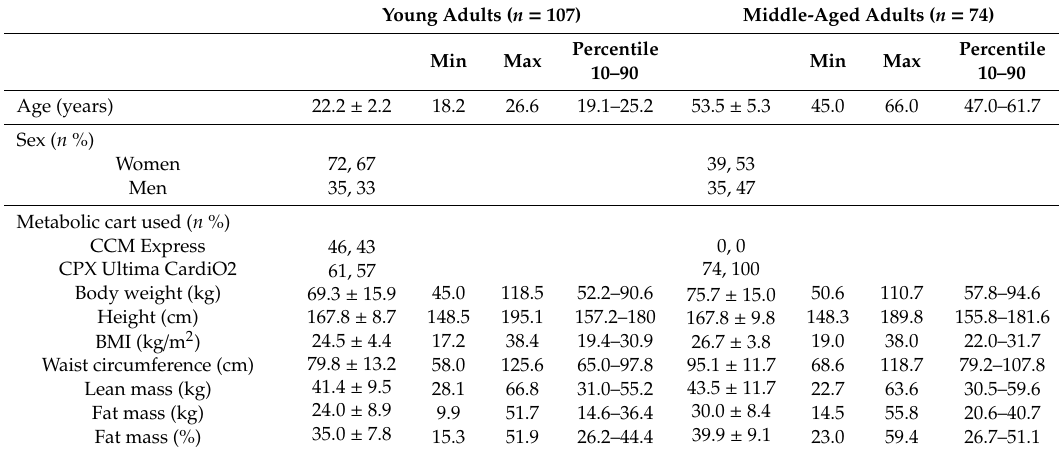
Table 1. Subject descriptive